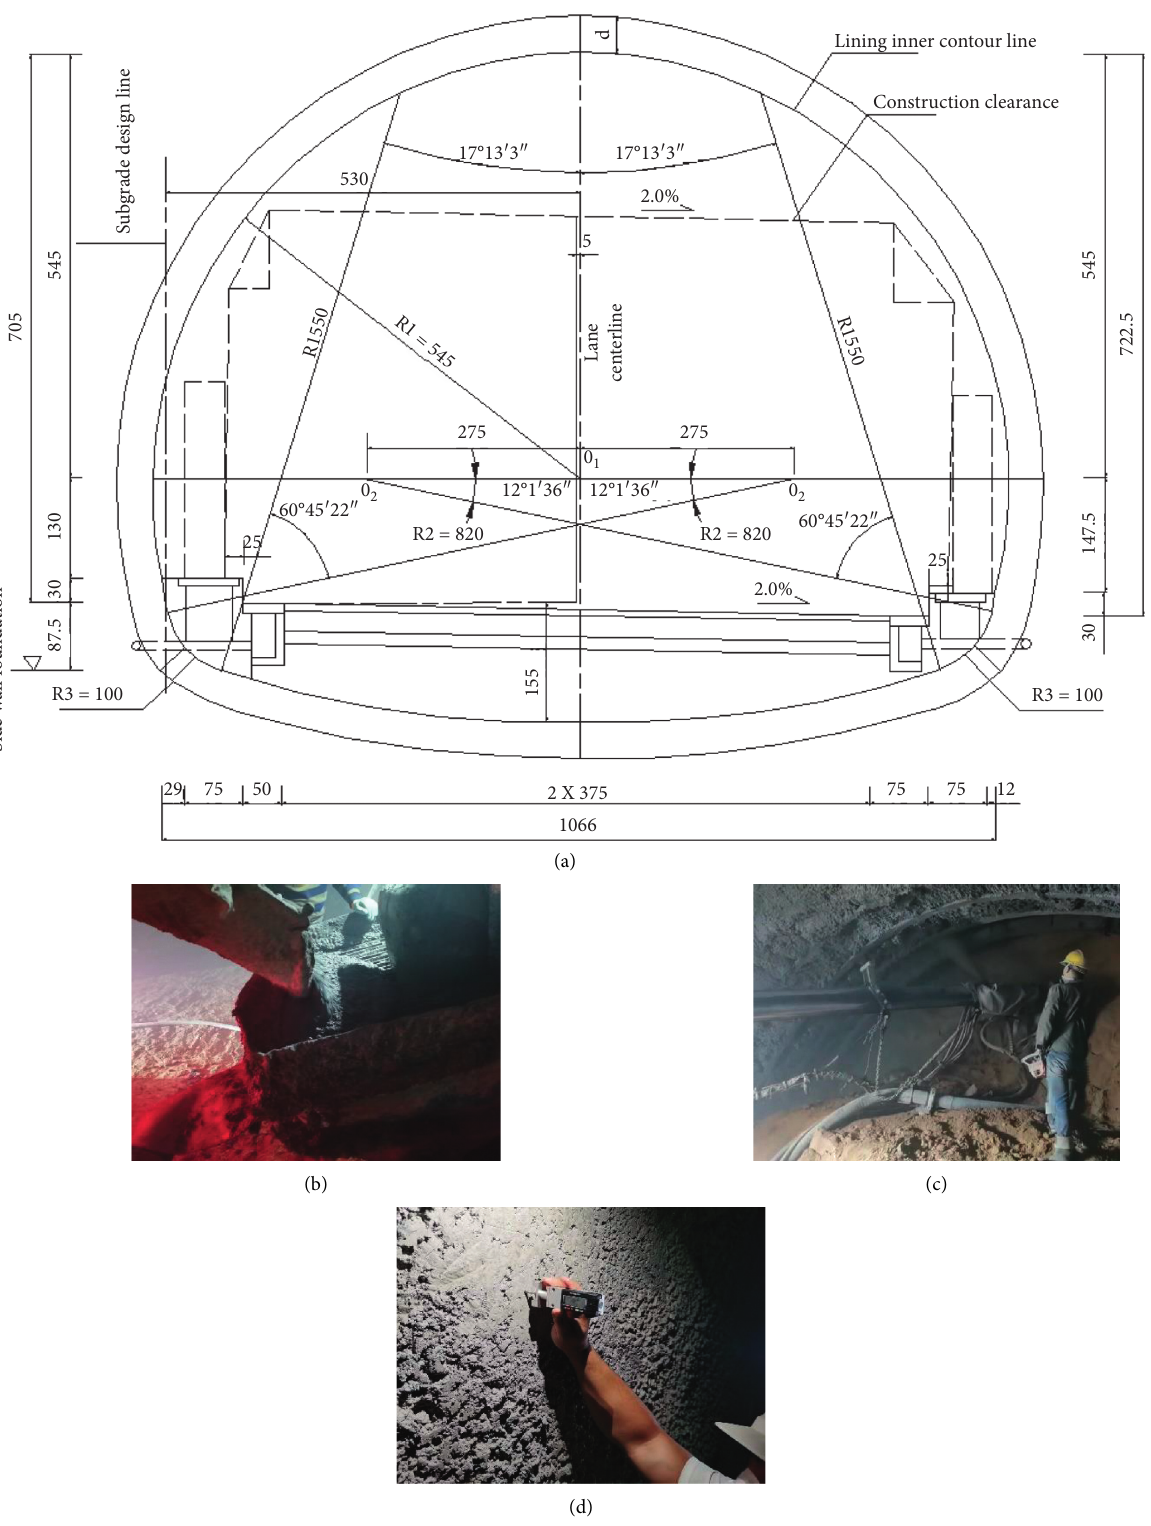
Figure 7: On-site construction process of DSS. (a) The standard cross section of the tunnel in the test section; (b) workability of DSS; (c) process of the wet spraying method; (d) reference of the nail shooting method for 1 d strength